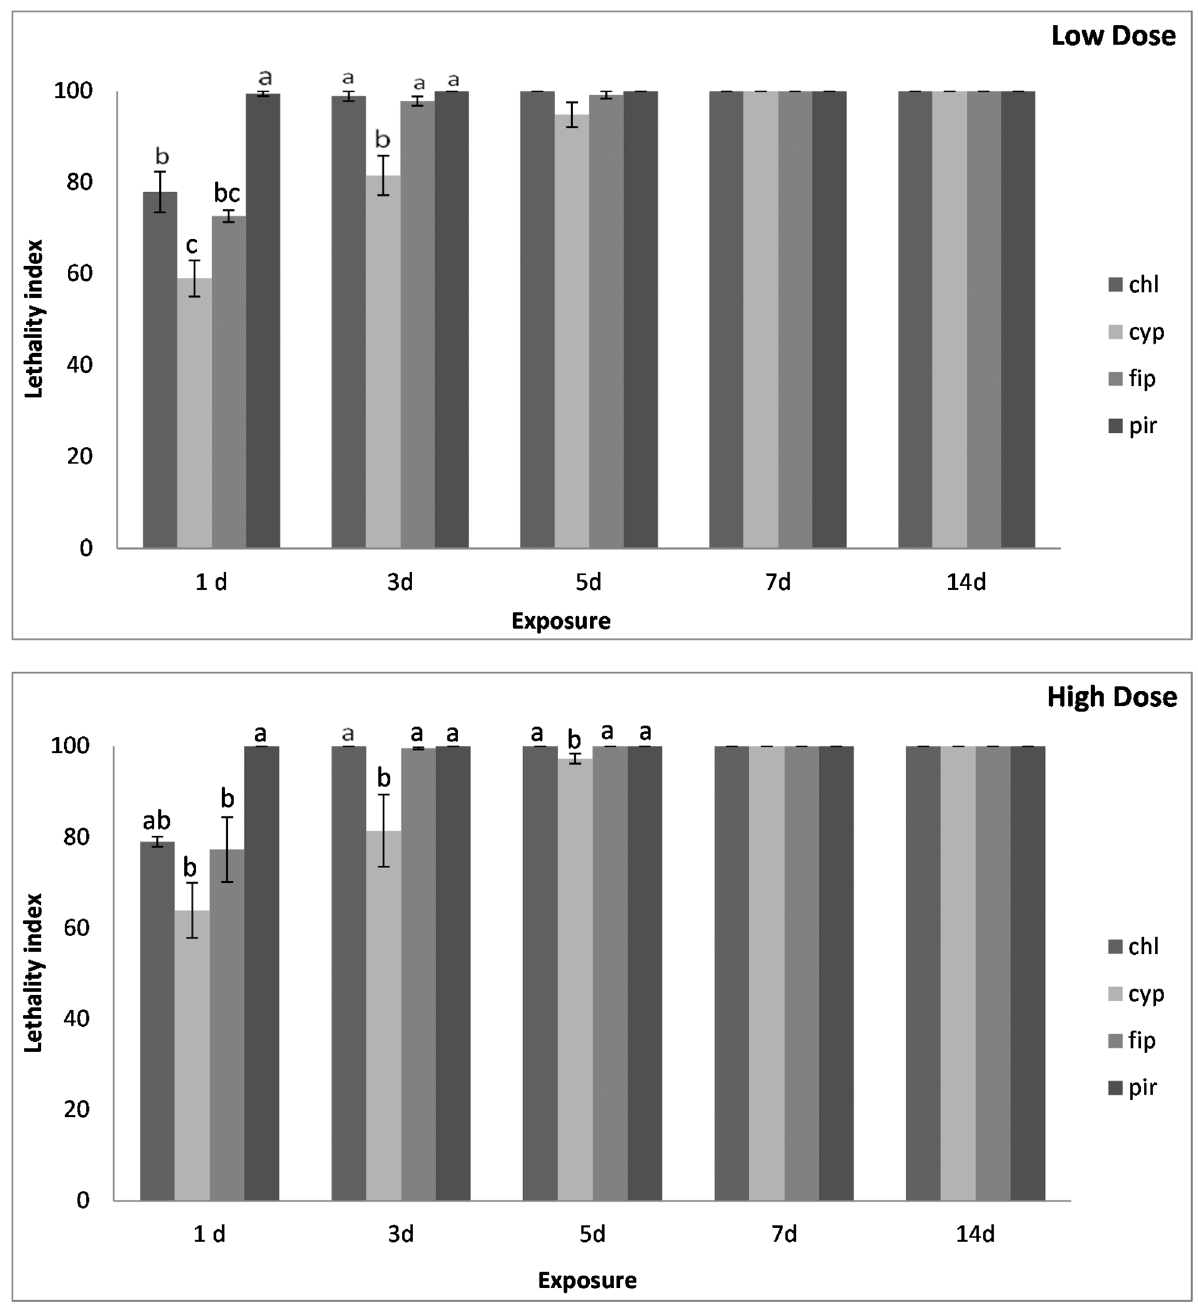
Fig 8. Lethality index of O . surinamensis adults on metal surfaces at low and high dose. Mean lethality index ( ± SE) of O . surinamensis adults on metal treated with chlorfenapyr (chl), alpha-cypermethrin (cyp), fipronil (fip) and pirimiphos-methyl (pir), at the low and the high dose rate of each insecticide after 1, 3, 5, 7 and 14 d of